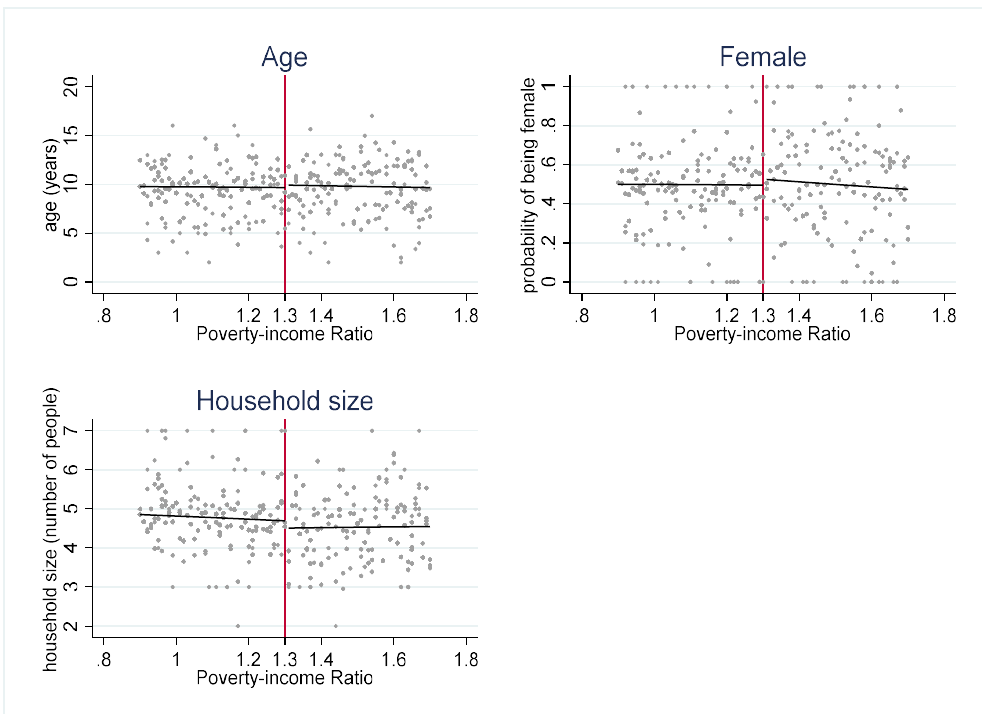
Figure 2. Observable characteristics around 1.30 poverty income ratio (PIR). Notes: Figure 2 plots the mean observable characteristics (age, gender, and household size) at each level of PIR. These graphs suggest that there are no systematic differences in multiple observable characteristics across the 1.30 PIR